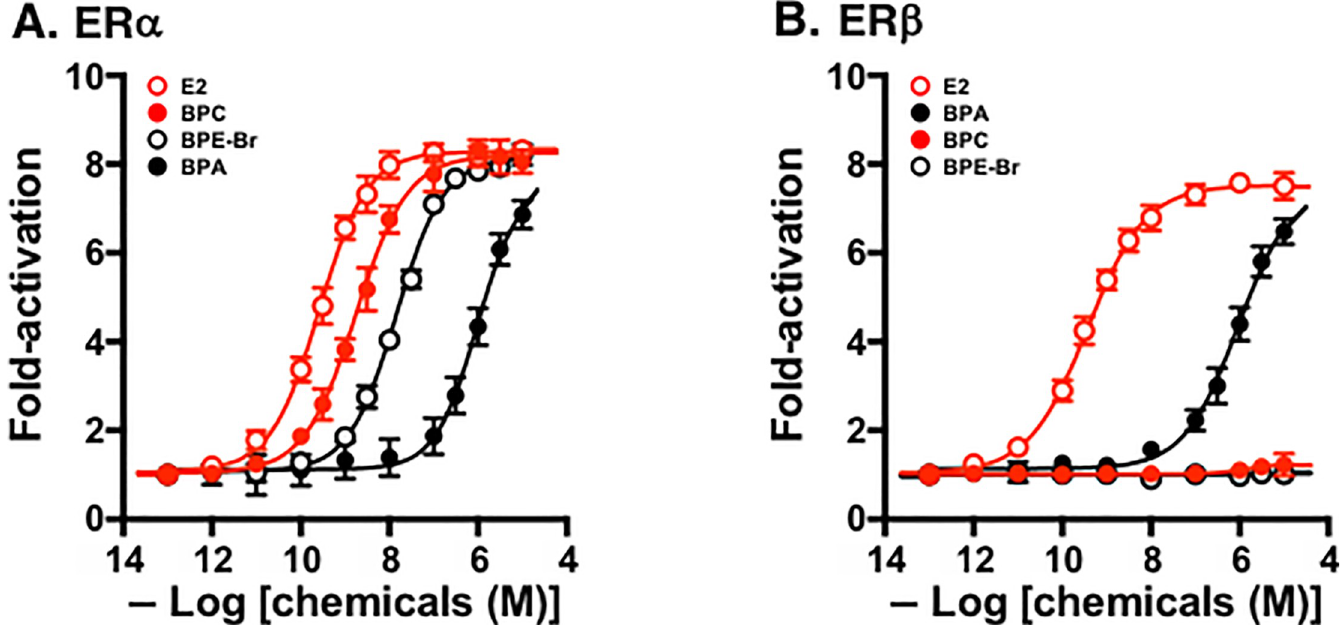
Fig 3. Luciferase reporter gene transcription activation assays. Dose-response curves are shown for the assays for ( A ) ER α and ( B ) ER β . E2 was used as an internal standard compound in the assays for ER α and ER β . Log[chemicals (M)] is the logarithm of the concentration of test chemicals plotted on the X-axis.